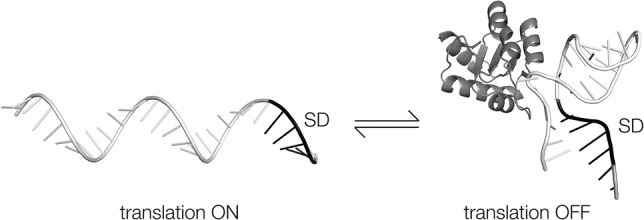
Cartoon showing the probable mechanism of regulation of translation by the binding of L7Ae to the 5′-UTR leader sequence. In the absence of the protein, the RNA is unstructured and the Shine–Dalgarno sequence (SD, black) is accessible, allowing translation to initiate. On binding L7Ae the stem–loop forms, stabilized by protein-k-turn binding. The Shine–Dalgarno sequence is now incorporated into the C-helix of the k-turn and thus occluded so that translation cannot be initiated.